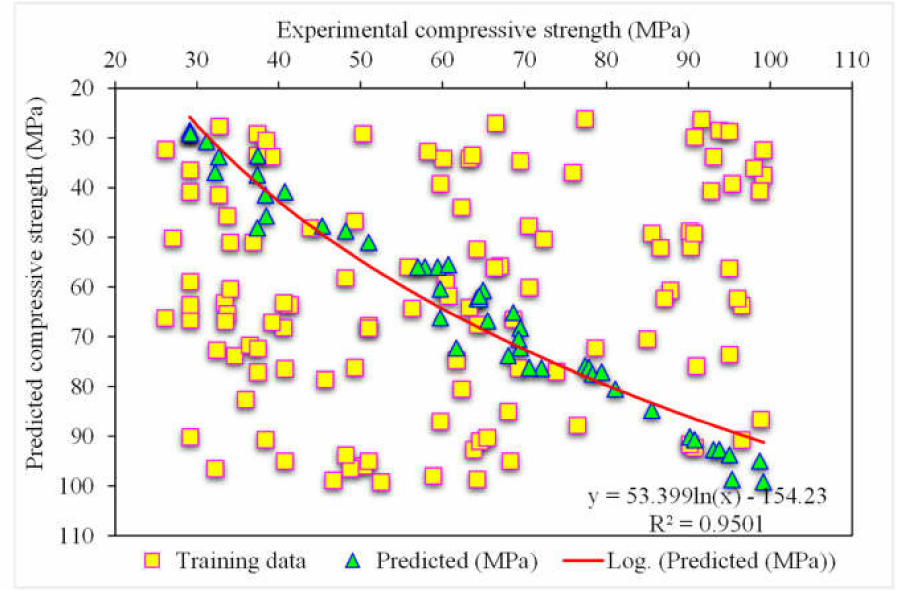
Figure 9. Experimental and gradient boosting predicted